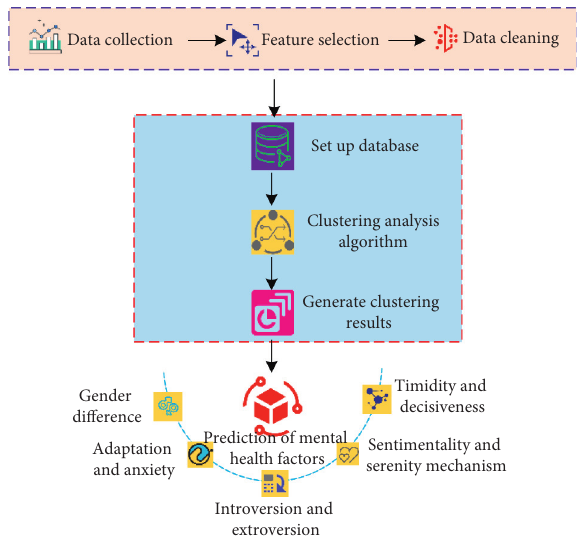
Figure 3: Data mining analysis chart of college students’ mental